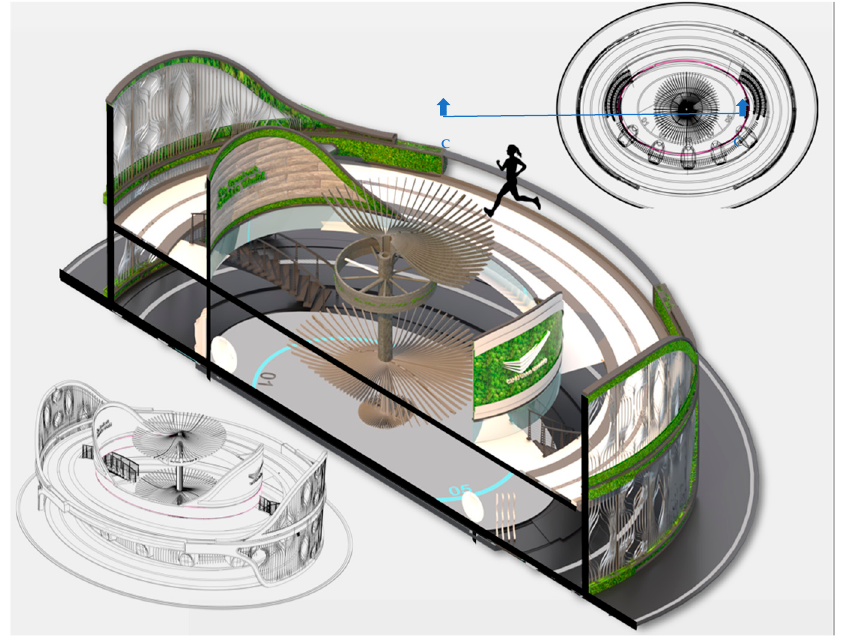
Figure 17. 3D section showing the double floor walking track, with the plan and 3D perspective (designed by the authors).